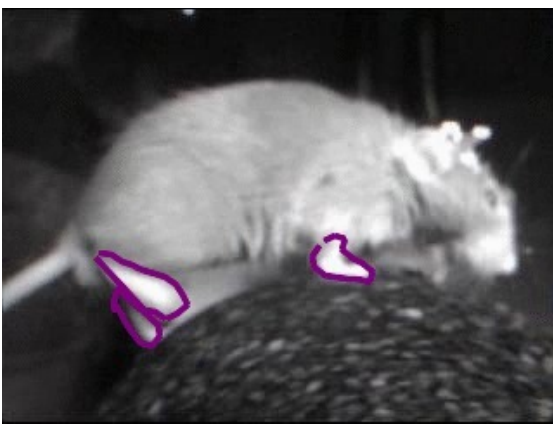
Figure 2. Lateral view of a mouse with its moving limbs